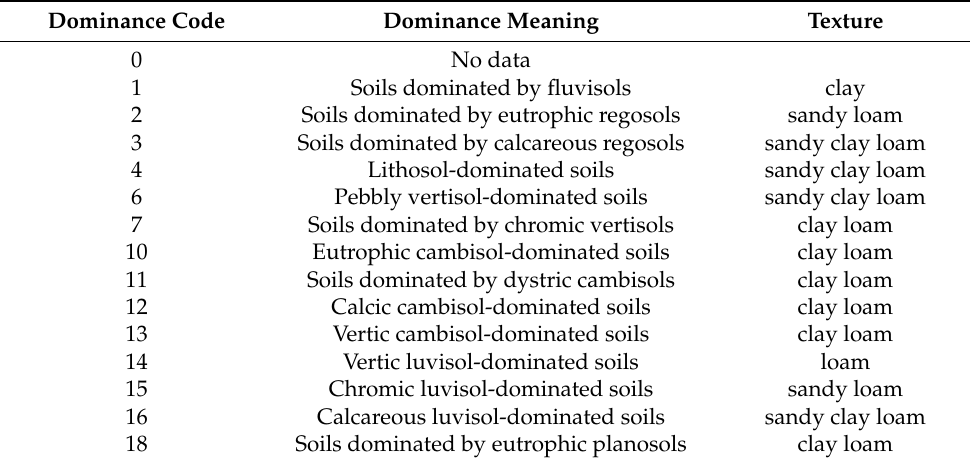
Table 2. Dominance edaphic codes unit and textures of the study